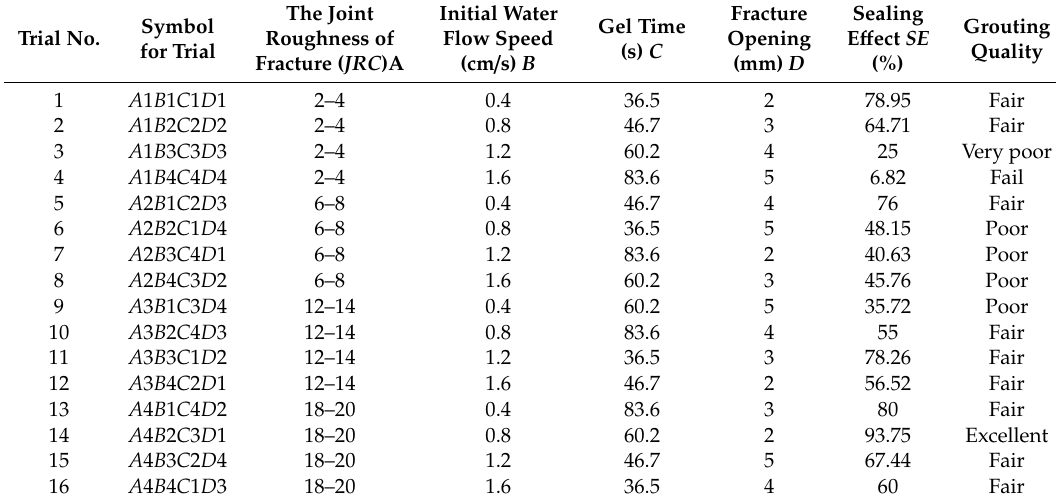
Table 4. Results of the orthogonal test of chemical grouting in a rough fracture with flowing water. Trial